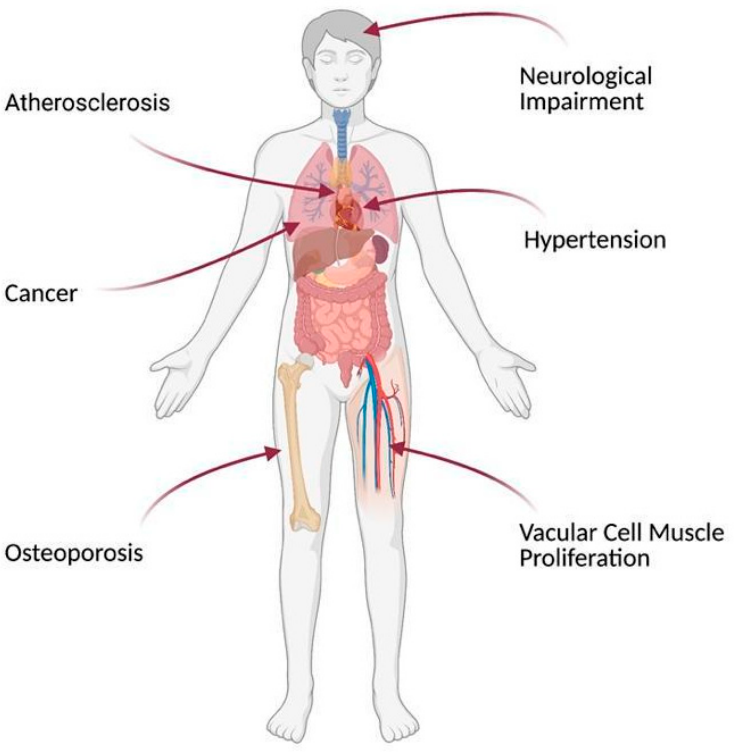
Figure 1. Possible targets for pleiotropic effects of acetylsalicylic acid in patients after coronary artery bypass grafting Figure created with BioRender.com.